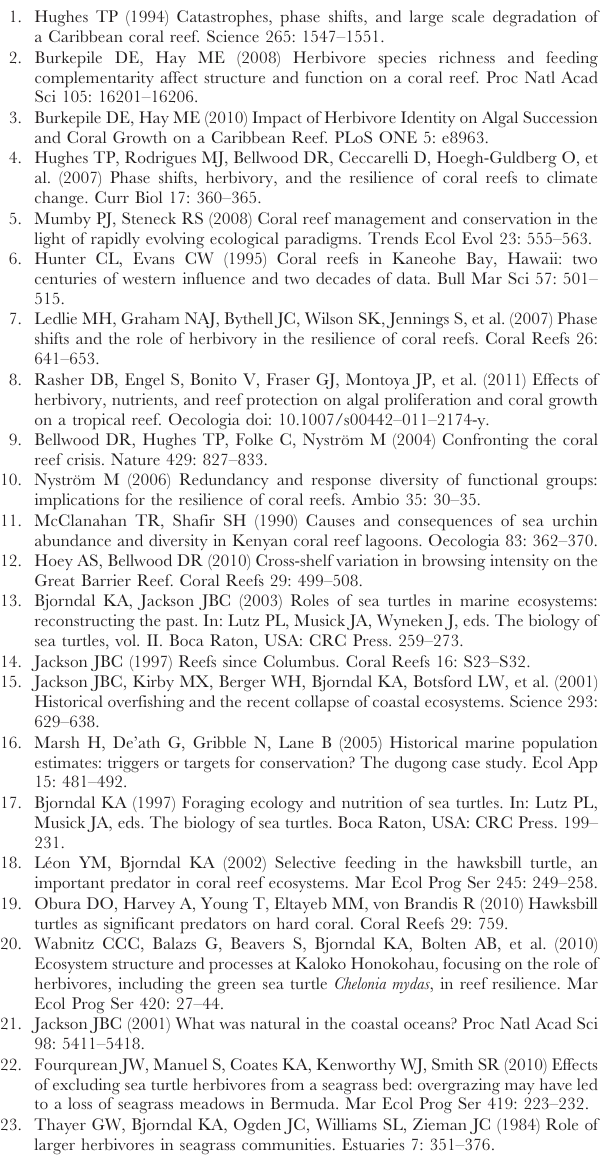
Table S1 Summary of previous dietary studies of the green turtle, Chelonia mydas . Values represent percent volume of each dietary category. Where quantitative estimates were not available {{ indicates the dominant component, and * indicates presence as a minor component. Literature cited referenced in Appendix S1. Table S2 Summary of previous dietary studies of the hawksbill turtle, Eretmochelys imbricata . Values represent percent volume of each dietary category. Where quantitative estimates were not available {{ indicates the dominant compo- nent, and * indicates presence as a minor component. Literature cited referenced in Appendix